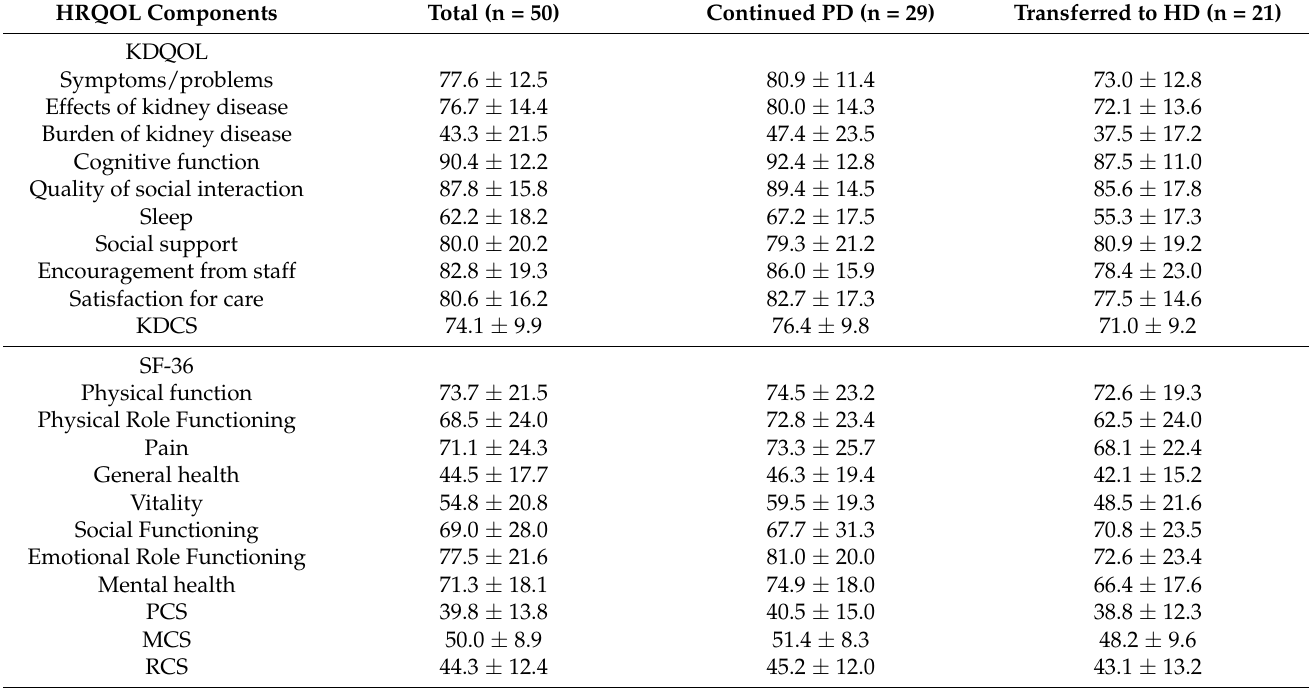
Table 2. Health-related quality of life (KDQOL/SF-36) scores of the study participants.